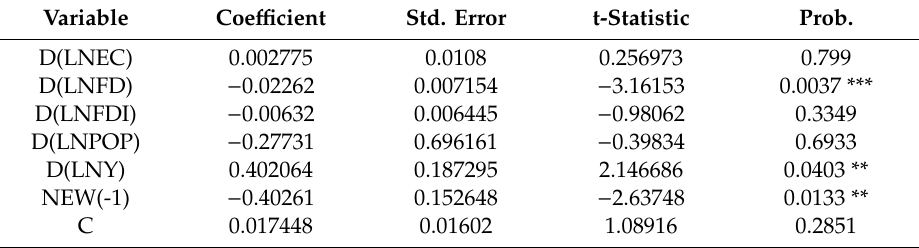
Table 8. Second step in Engle Granger cointegration test for significance